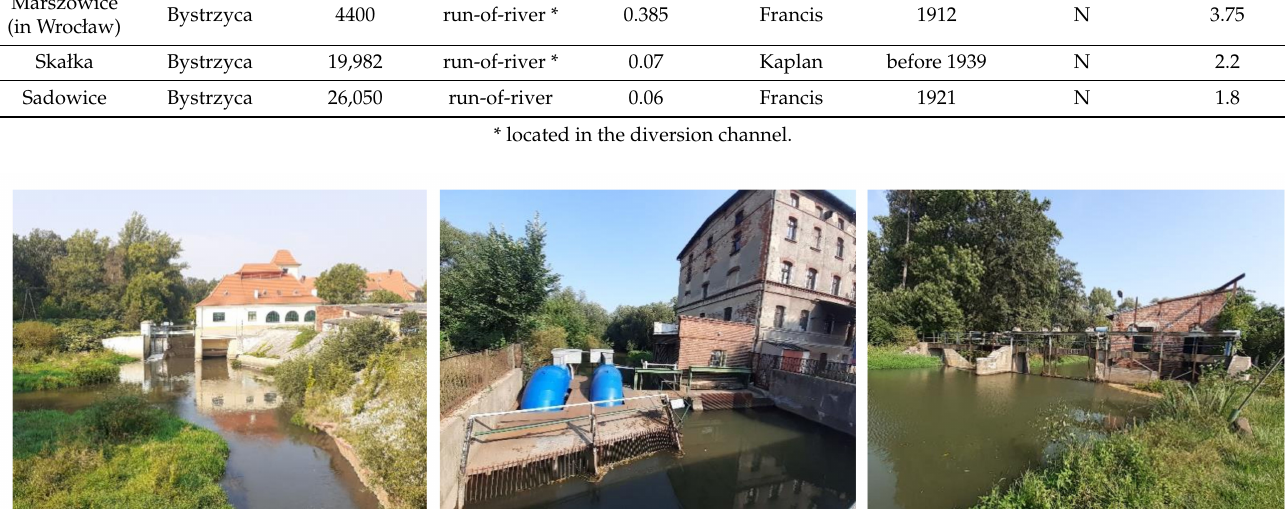
Figure 2. Research facilities (from left): Marszowice, Skałka, and Sadowice hydropower plants.